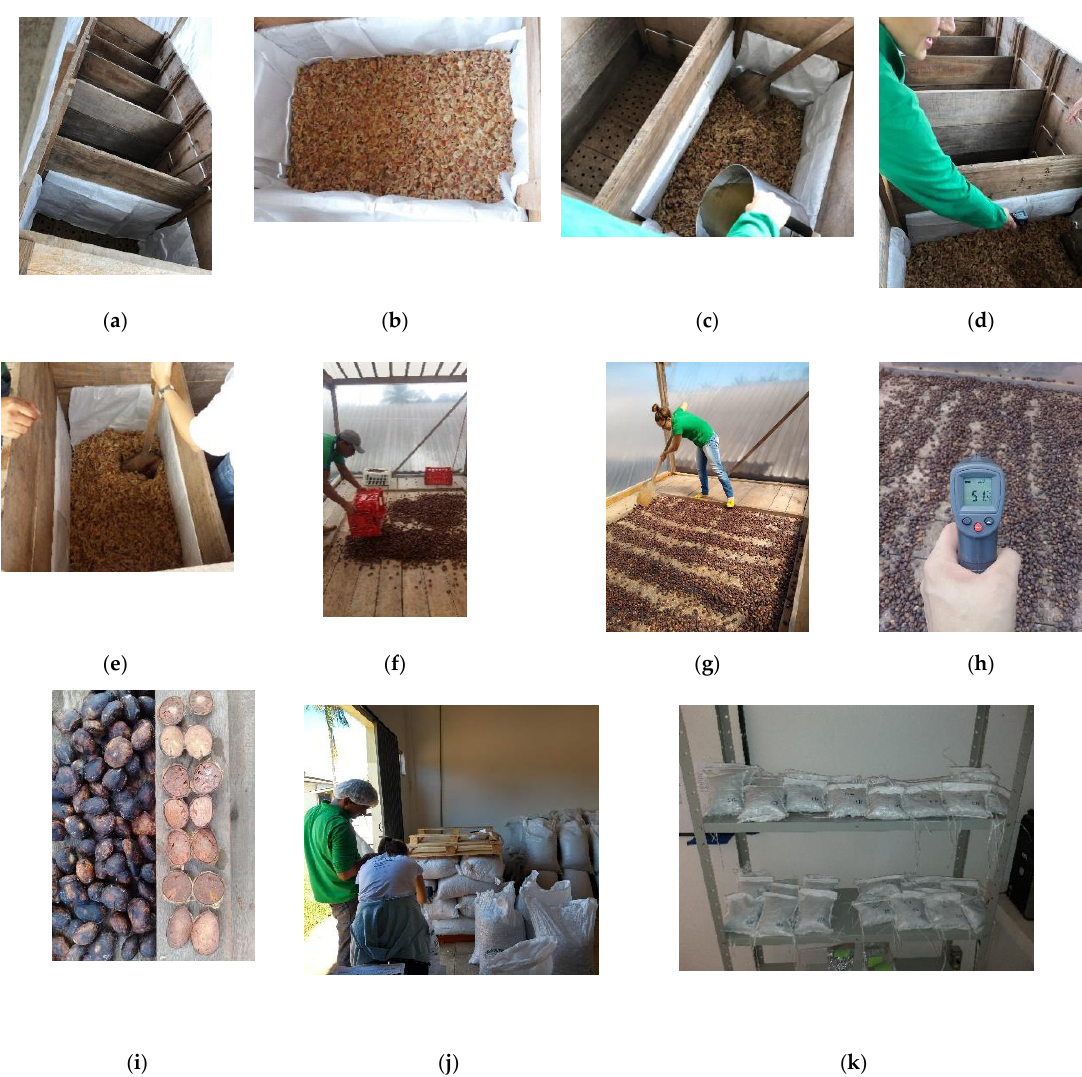
Figure 3. Pictures of Cupuaçu ( Theobroma grandiflorum ) processing: ( a ) Wooden fermenter with 5 compartments (boxes) placed in a greenhouse structure; ( b ) Pulped cupuaçu seeds used for fermentation; ( c ) Adding 30% ( w/w ) aqueous sucrose solution to the seeds in a proportion of 1% ( w/w ); ( d ) Twice daily temperature measurements during the fermentation process; ( e ) Twice daily manual turns of seeds during the fermentation process; ( f ) The same greenhouse structure used to dry the seeds in the solar terrace; ( g ) Twice daily manual turns of beans during the drying process; ( h ) Twice daily temperature measurements during the drying process; ( i ) Cupuaçu beans at the end of the drying process; ( j ) Packing dry beans in 60 kg polypropylene (raffia) grain bags; and ( k ) Dried beans samples packed in 600 g polypropylene (raffia) grain bags for storage studies at the Embrapa facilities. Courtesy of authors J.M.L.S., C.B.C.C., M.A.M.V and S.K. Rio Branco, Acre, Brazil.